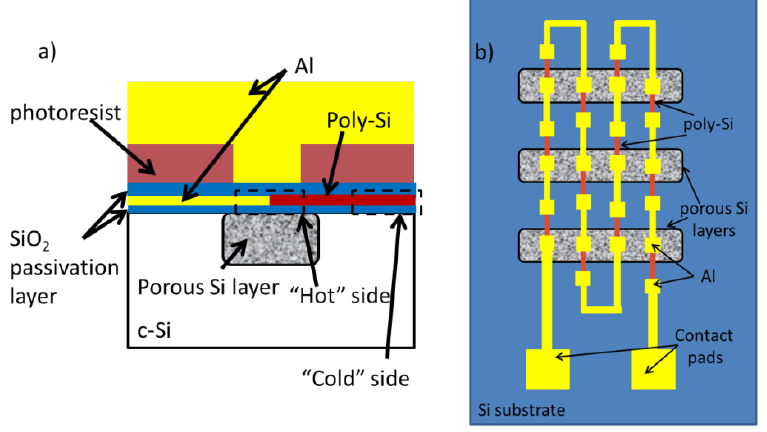
Figure 1. ( a ) Schematic cross sectional view of one part of the thermoelectric generator, illustrating the local porous Si areas, the hot contacts of the thermocouples on top, the patterned photoresist layers that provides thermal isolation between the hot and cold contacts of the thermocouples and the Al thermal bath that transfers the external thermal differences on the hot contacts of the thermocouples; ( b ) Schematic representation of a small number of thermocouples connected electrically in series and thermally in parallel, illustrating the hot contact of the thermocouples on porous Si and their cold contact on bulk crystalline Si. Polysilicon lines are shown in red, while Al lines in yellow.